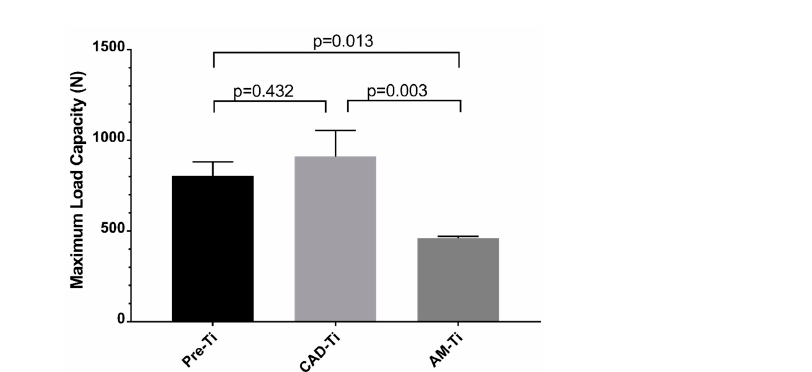
Figure 4. Bar graph showing the mean maximum load capacity was significantly higher for both original equipment manufacturer (OEM) titanium abutments (Pre-Ti and CAD-Ti) than for aftermarket abutments (AM-Ti). Comparisons were done by one-way ANOVA (P < 0.005) followed by group-to-group